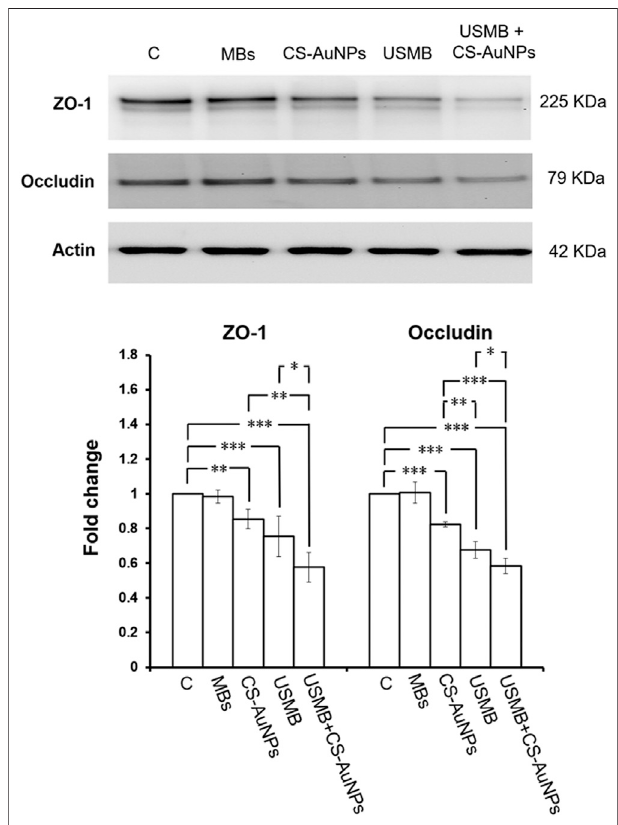
FIGURE 13| Representative western blot analysis ofZO-1 and occludin protein levels of the RWM (upper panels) after CS-AuNPs or USMB-aided CS-AuNPs treatments and digital quanti fi cation (lower panels) . The extracted proteins of untreated RWM served as control. The treatment period was 30 min for CS-AuNP soaking alone or for CS-AuNP soaking following aprior USMB exposure.Both ZO-1 and occludin protein amounts in the RWM were reduced after the CS-AuNPs treatment. This reduction was noticeable in the group given a USMB exposure alone and in the group subjected toCS-AuNPssoaking after aprior USMB exposure. The results are expressed as the mean ± standard error of the mean for the fold change in protein expression level relative to the control, with n (cid:2) 4 for each bar. ** p < 0.01; *** p < 0.001; C, control; MBs, microbubbles; Immed, immediate; control, mouse group not exposed to USMBs; US, ultrasound; USMB, ultrasound